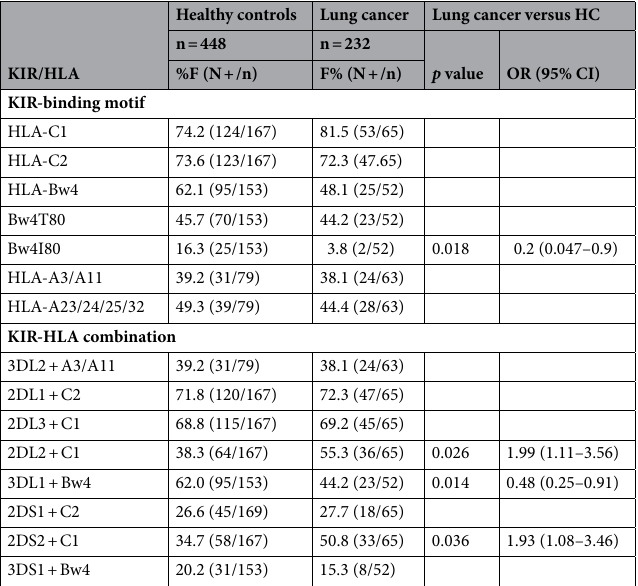
Table 3. Frequency of KIR-HLA combinations, and HLA class-I ligands among patients with lung cancer and healthy controls. N + number of individuals positive for the gene, n number of individuals tested for the gene, HC healthy control, OR odds ratio, CI confidence interval. p < 0.05: statistically significant; based on two-tailed Fisher’s exact test.